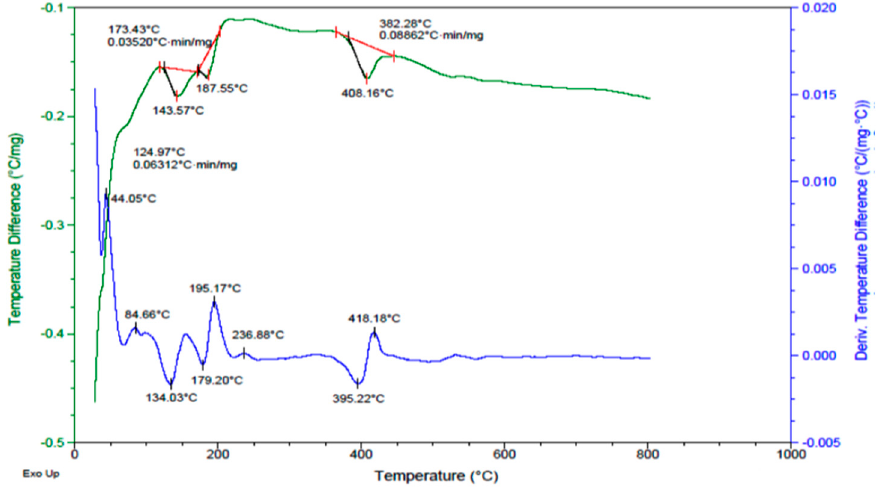
Figure 4. DTA-TGA of diopside particles dried at 120 °C.